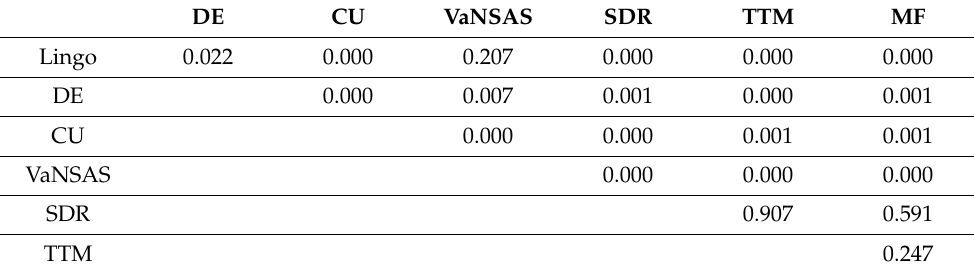
Table 10. Statistical test of small test instances.